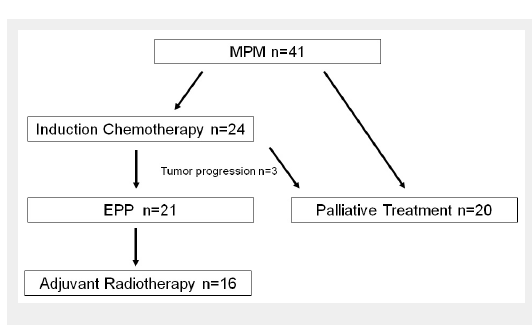
Flow chart showing the patient included in the trimodal or palliative treatment groups.